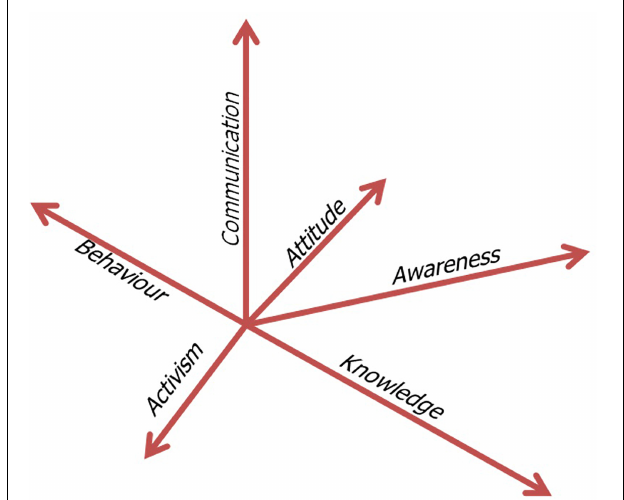
FIGURE 1 | The Ocean Literacy